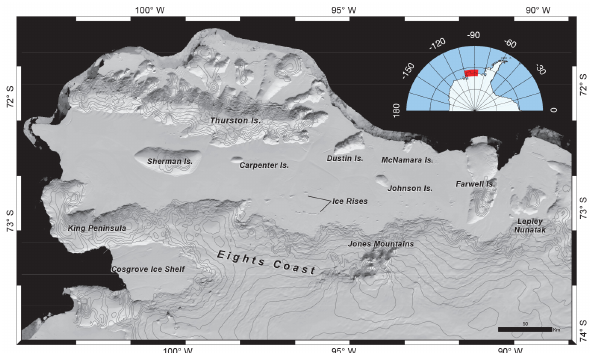
Fig. 1. MODIS MOA image of the Abbot Ice Shelf from 2004 show- ing the location of features mentioned in the text. Contours are from the Bamber et al. (2009) DEM, contoured at 100m intervals. Inset shows its position on the West Antarctic